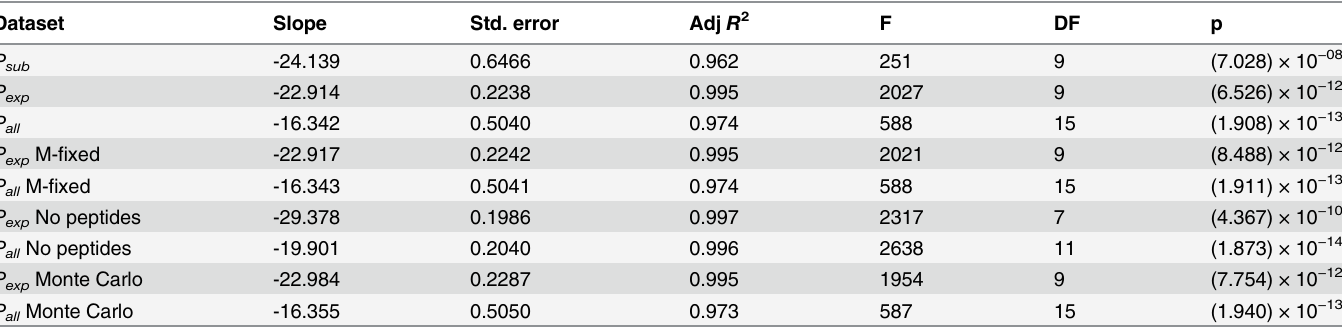
Table 5. Analysis of the Impact of Potential Bias in the SwissProt dataset. Bias was assessed in terms of impact on the fit statistics for power-law behav- iour in the tail of the unique amino acid count distribution, which is addressed in detail in the following sections as prediction P1, (see also Fig 1A). Datasets a P a P a P sub ( i = 20 to 30), exp ( i = 20 to 31) and all ( i = 20 to 37), were analyzed as extracted from SwissProt and are described in Methods. The fit statistics for the power-law tail were then compared with the equivalent fit statistics on datasets corrected for potential bias in treatment of the initiating methionine (M- fixed), inclusion or exclusion of signal peptides (No peptides) and Monte-Carlo exploration of the ambiguity of unique amino acid counts as described in Meth- ods. The fit statistics are remarkably resilient with respect to all three different possible sources of bias, and the robust linearity of the power-law tail in all con- ditions is emphasized by the high values of the adjusted R 2